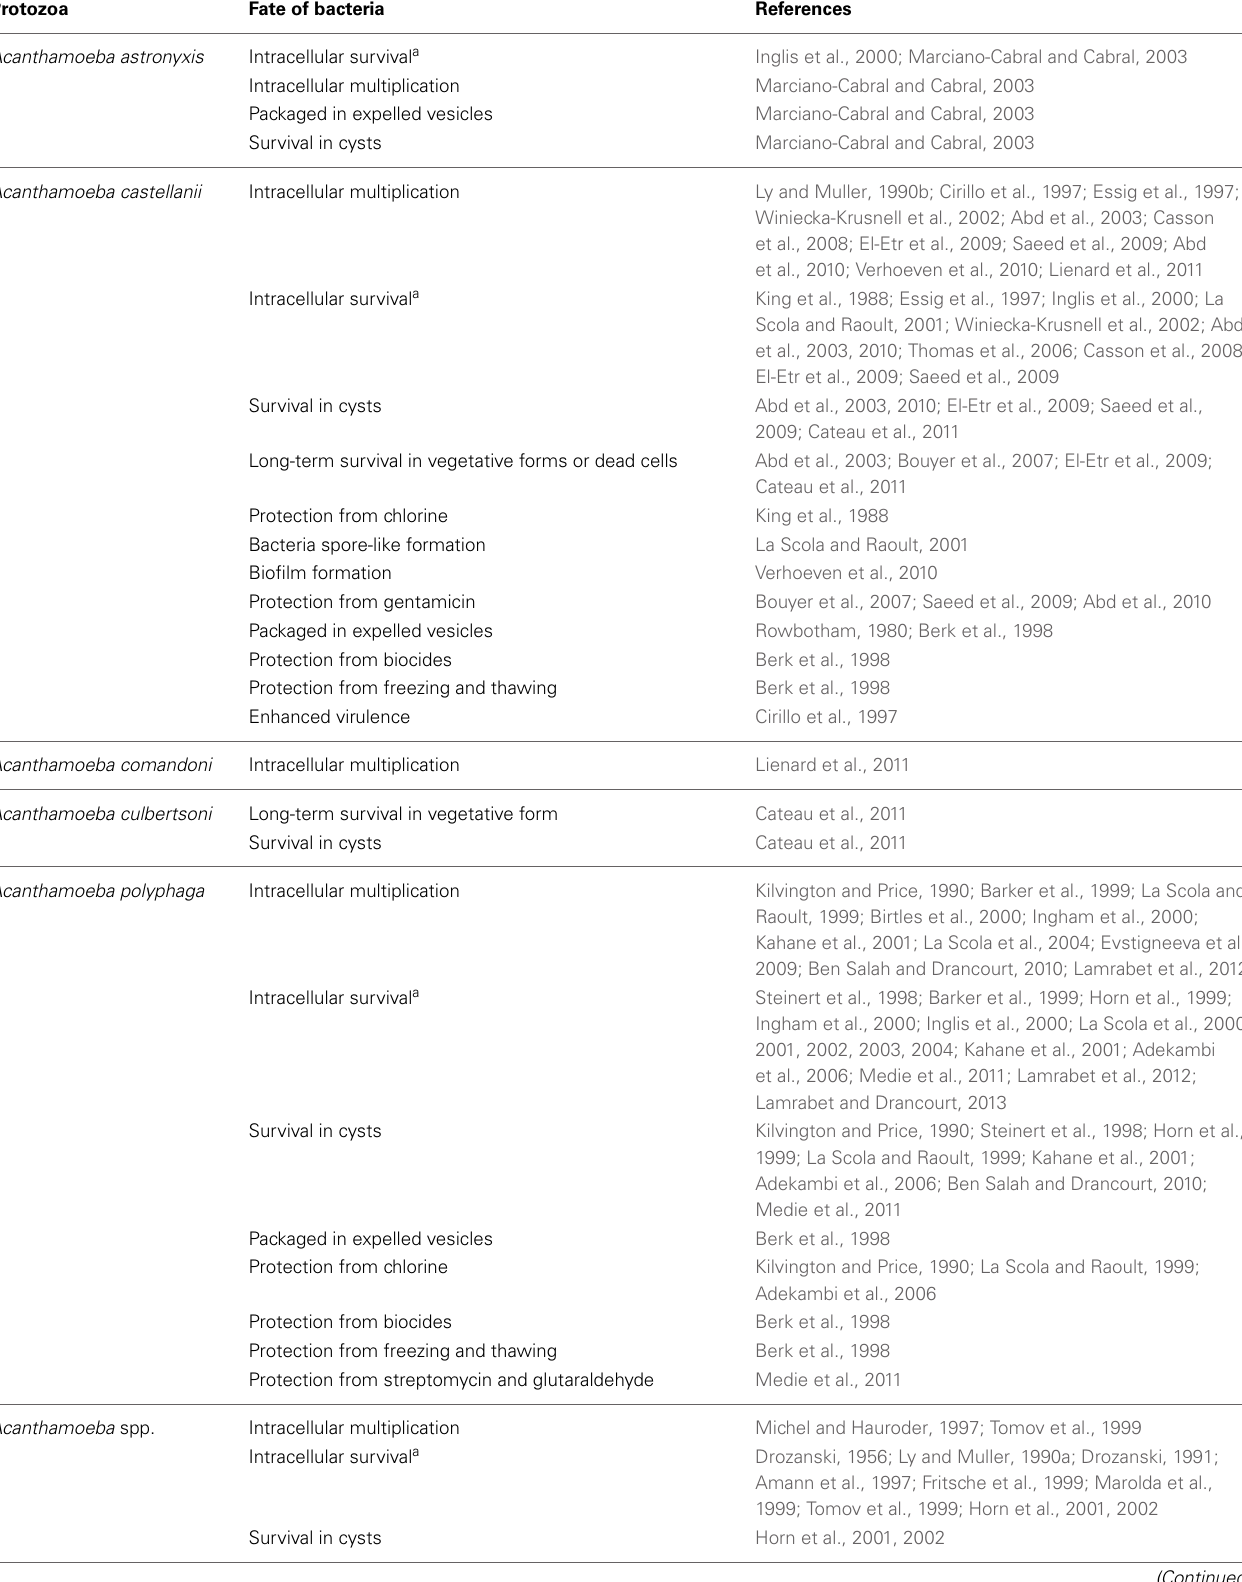
Table 1 | Fate of bacteria following interactions with